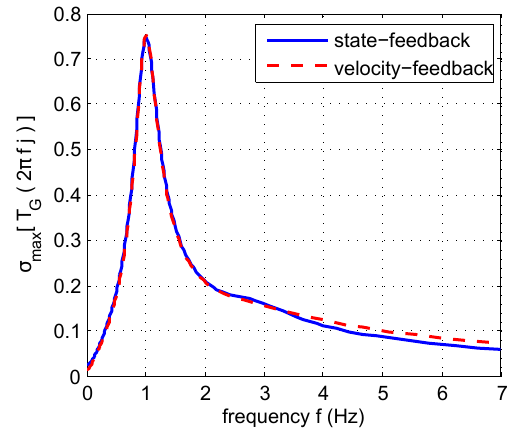
Figure 11: Decentralized velocity-feedback controller with L = 0. Maximum singular values of the closed-loop pulse transfer functions corresponding to the decentralized velocity- feedback controller u ( t ) = (cid:98) K ( d ) y ( t ) (red dashed line) and the optimal state-feedback controller u ( t ) = (cid:101) G s x ( t ) (blue solid line)